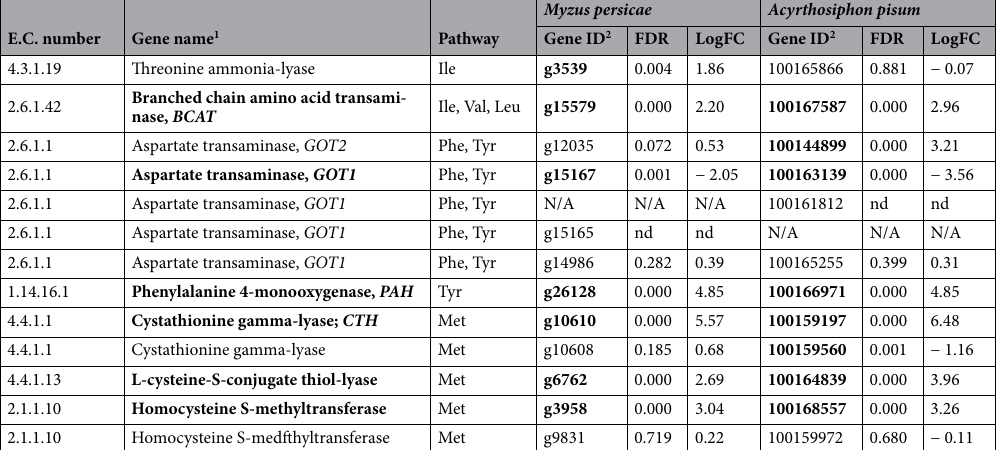
Table 1. Expression of collaborative essential amino acid aphid orthologs in bacteriocytes compared to body tissues for two different aphid species. Each row contains a shared ortholog between M. persicae and A. pisum except for N/A which indicates no ortholog was identified between species 1 Bolded Gene names indicate orthologs in both aphid species are significantly differentially expressed between bacteriocytes compared to body tissues where both FDR p-value ≤ 0.05 and fold change (FC) ≥ 1.5 (i.e. LogFC ≥ 0.5849)). 2 Bolded Gene IDs indicate that the aphid gene is significantly differentially expressed between bacteriocytes compared to body tissues in that aphid species. nd= not